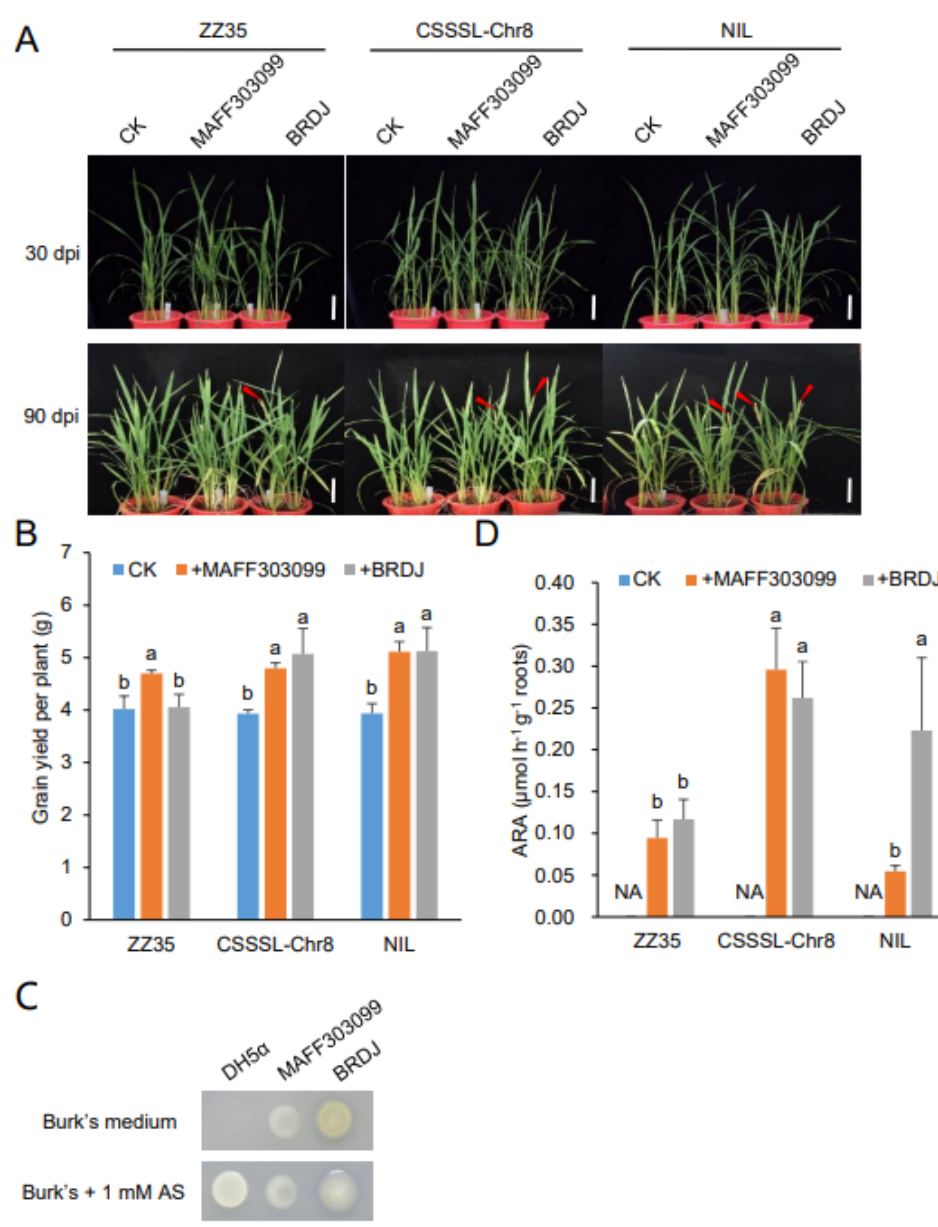
Figure 1. Plant growth promoting activity of BRDJ. ( A ) Representative images of greenhouse experiment. Inflorescence marked by red arrowhead. NIL, near-isogenic line; CSSSL-Chr8, chromosome eight single-segment substitution line. Scale bars, 10 cm. ( B ) Grain yield of harvested rice grown in greenhouse conditions. For each cultivar, nine plants were measured. Values are presented as means ± SD. Different letters indicate significant differences among treatments (Fisher’s Least Significant Difference test, p < 0.05). ( C ) Comparative growth of Escherichia coli DH5 α , Mesorhizobium loti